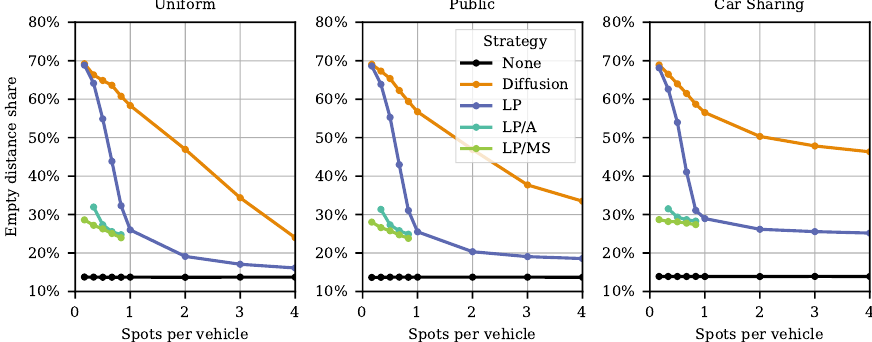
Figure 3. Evolution of the empty share for the different strategies depending on the number of parking spaces. (A = Depot at airport; MS = depot at the main